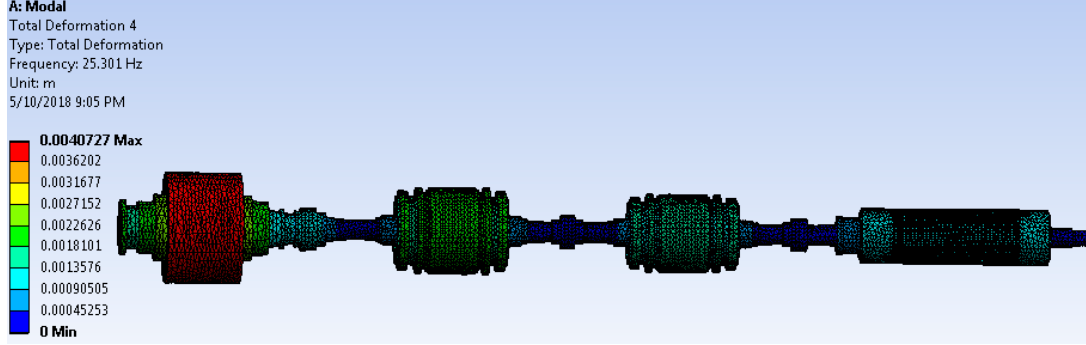
Figure 17. Concept 2 Mode 5 torsional natural frequency and deformation. In each Figure, the torsional natural frequency of vibration is indicated and the colors red and blue indicate maximum and minimum deformation (mode shapes when animated), respectively. In Figure 14, the 22.9 Hz mode can be visualized as the HPT rotor and the Generator rotor oscillates in the same direction, as opposed to the LPT rotor. In Figure 15, the 108.9 Hz mode, the largest deformation is at the locations of the L-0 blades (possibly due to the centrifugal forces of the lumped inertia blades) and the LPT rotor body is oscillating in the opposite direction. Figure 16 shows that the Mode 3 frequency is 25.3 Hz and the largest deformation is at the HPT rotor, which is oscillating in the same direction with the generator rotor with counter-rotation by the two (2) LPT rotors. In Figure 17, the frequency is 158.7 Hz and the largest deformation is on the LPT rotors that are oscillating in the same direction.